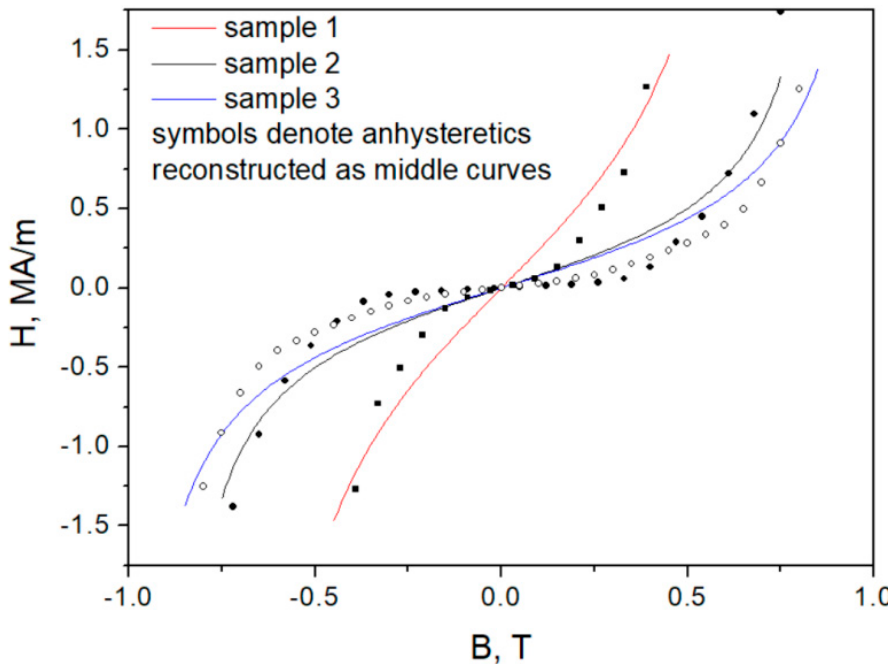
Figure 7. Fitting of anhysteretic curves recovered as the middle curve from the loop branches using just one fitting parameter γ in the Cohen relationship. Dots—measurement points, lines—modelled curves. Table 3. The estimated values of γ parameter used to model curves presented in Figure 7.